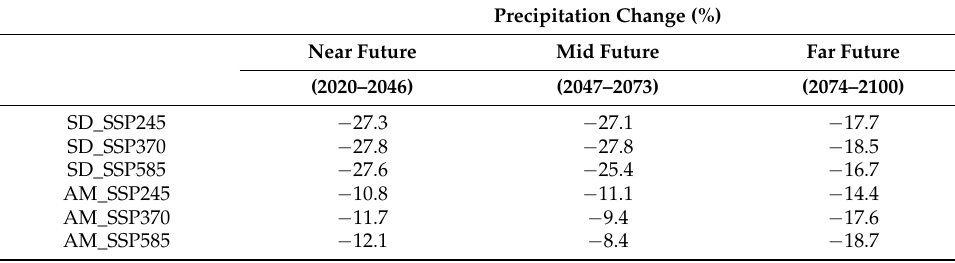
Table 6. Changes in future precipitation in comparison to observed mean of 3041.2